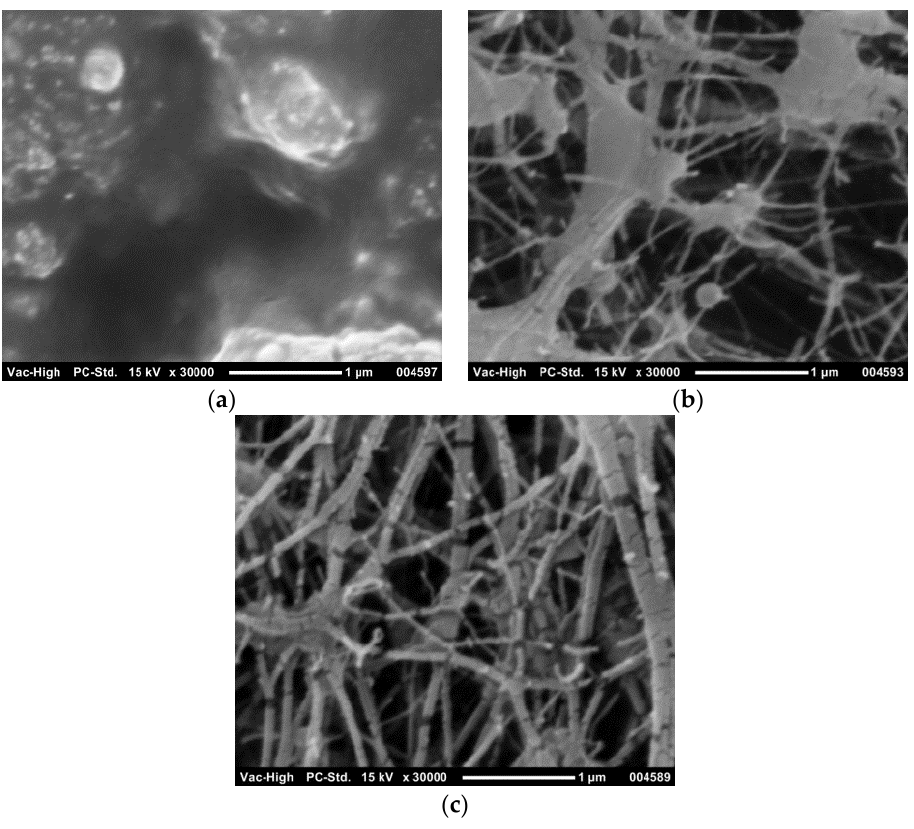
Figure 5. Scanning electron microscopy (SEM) image of the PU-PTFE membrane top surface ( a ) and bottom surface ( b ), and of the standard PTFE membrane top surface ( c ).